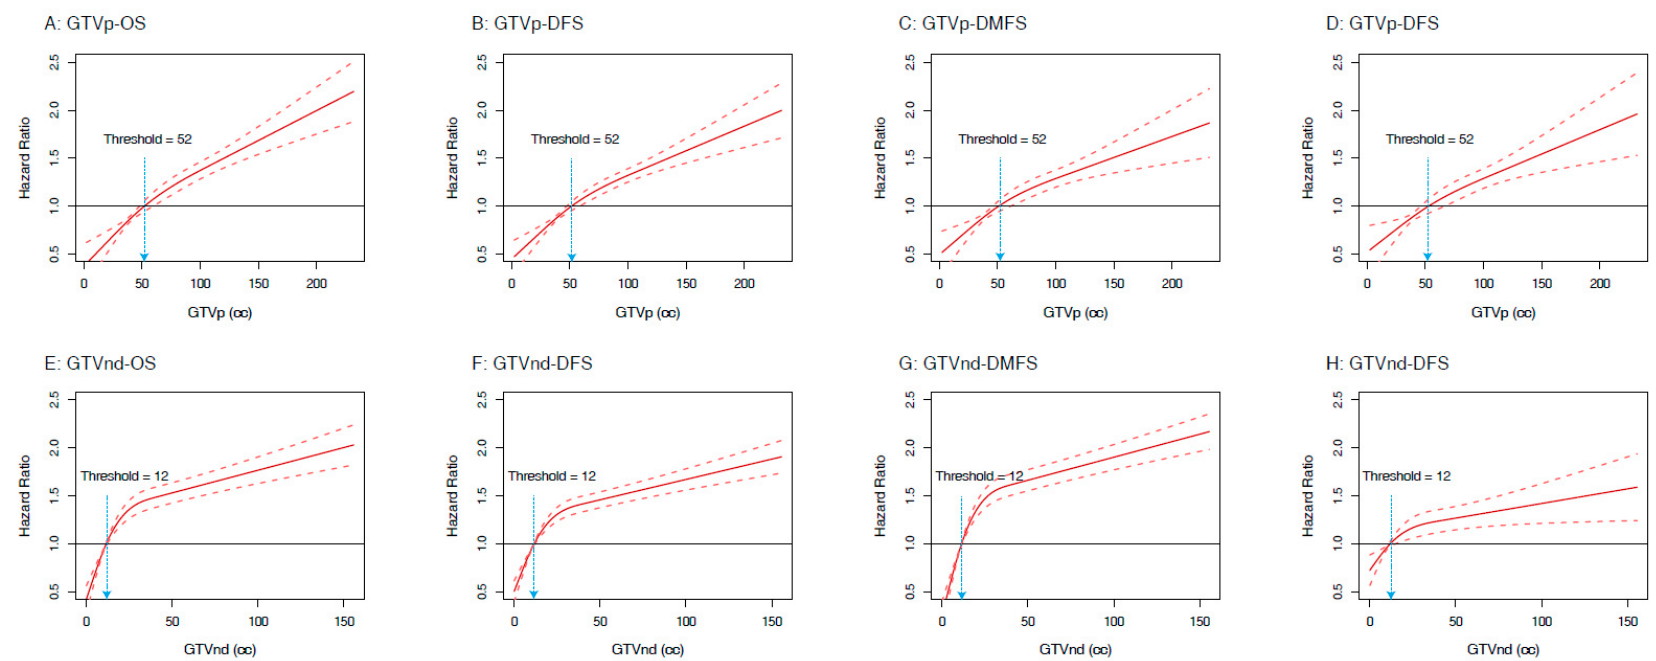
Figure 1. Estimated hazard ratios (HRs) (solid lines) with 95% confidence intervals (dotted line) for the association of post-neoadjuvant chemotherapy gross primary tumor (GTVp) and lymph node (GTVnd) volumes with overall survival (OS), disease-free survival (DFS), distant metastasis-free survival (DMFS), and local relapse-free survival (LRFS) in 4109 patients. The prognostic effects of GTVp on the risks of treatment outcomes are modeled with a restricted cubic splines (RCS) expansion, with GTVp/GTVnd as continuous covariates. The risk (in HR) of OS, DFS, DMFS, and LRFS increased along with the augment of GTVp.